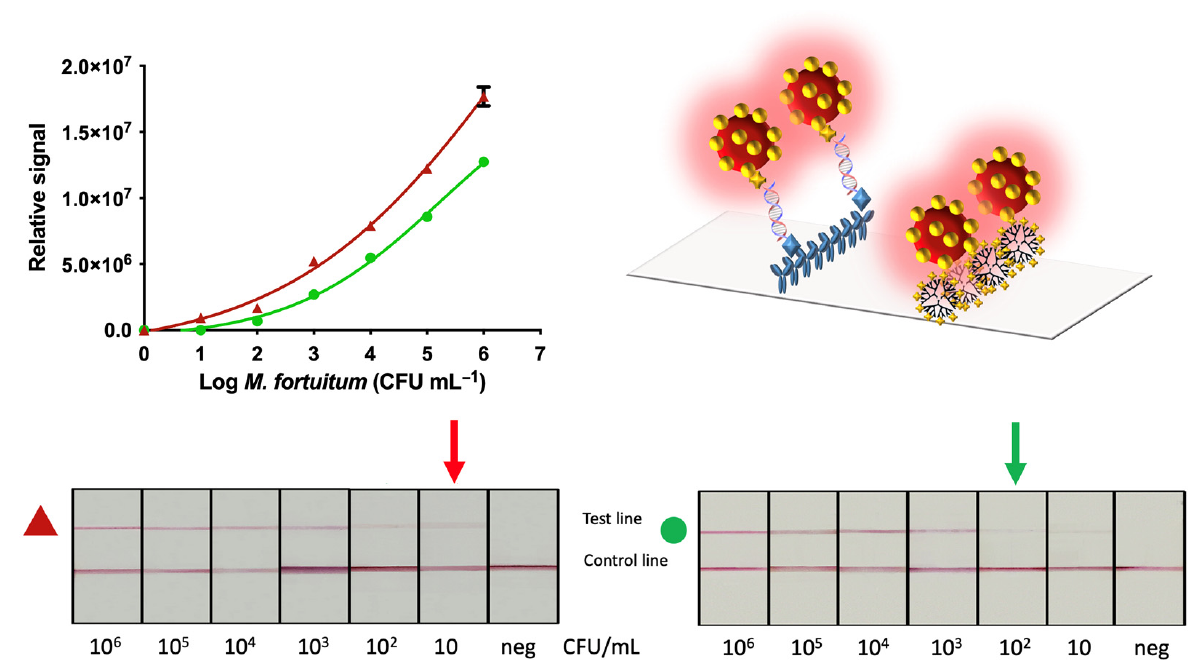
Figure 7. Results obtained for the NALF for different CFU of M. fortuitum submitted to immunomagnetic separation and preconcentration by magnetic actuation ( ▲ ) and with no magnetic preconcentration ( ● ). The negative control for the evaluation of non-specific binding is also shown.